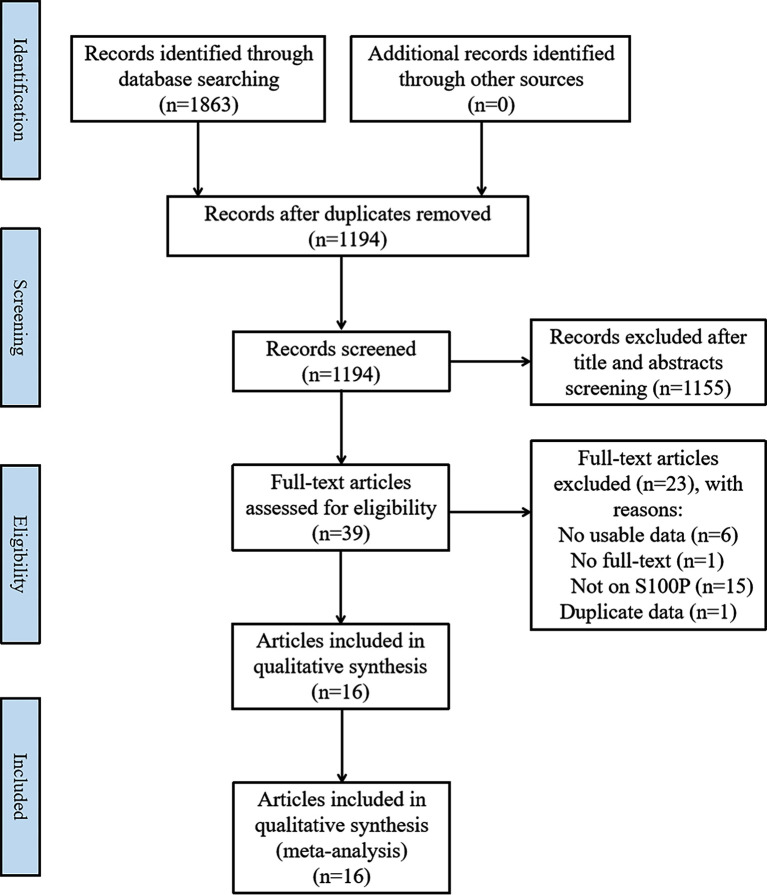
Flow diagram of the search and selection process.